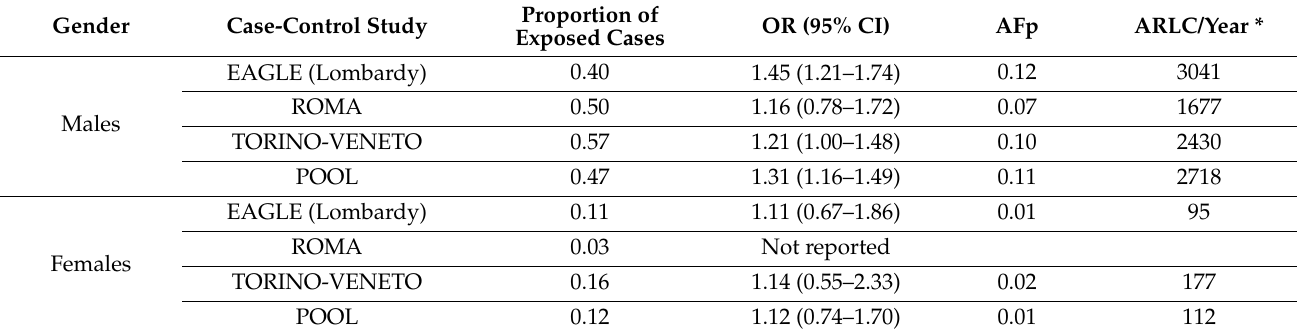
* Rounded to the nearest integer. Proportion of exposed cases: exposed cases/overall cases; OR: Odds Ratio; CI: Confidence Interval; AF p : asbestos attributable fraction in population; ARLC/year: asbestos-related lung cancer deaths, by year. The ratios between ARLC and mesothelioma (R = ARLC/MM) for each working sector of occupational cohorts, along with estimated ARLC and MM deaths in the corresponding